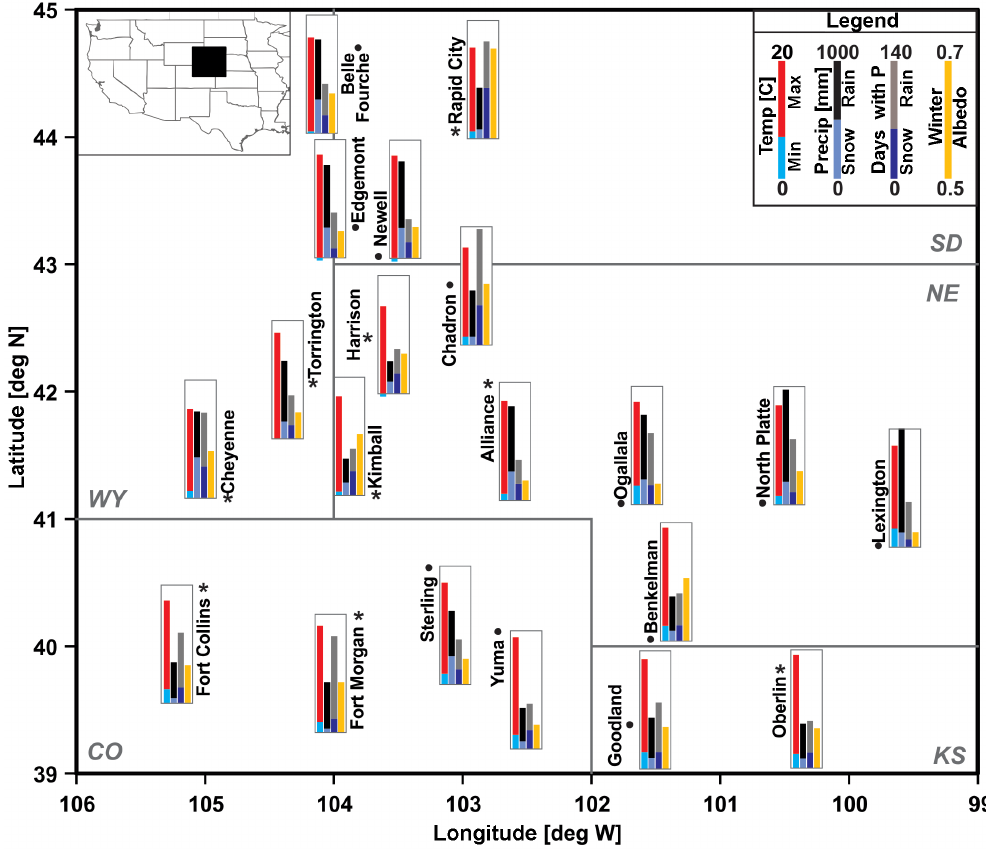
Figure 1. Location map and average climate from 1951 to 2010 for the 20 study stations in the Northern Great Plains. The annual climate summary includes the temperature (temp) as daily maximum (max) and minimum (min), precipitation (precip) as the sum of rain and snow shown separately, days with precipitation (days with P ) as the sum of days with rain and days with snowfall shown separately, and the winter albedo. The precipitation as snow is the amount of precipitation when fresh snow was observed, as defined by Huntington et al. (2004); the days with snowfall are the days when fresh snow was observed. The winter albedo is modelled. The nine stations that are part of the U.S. Historical Climate Network (HCN) are identified with an